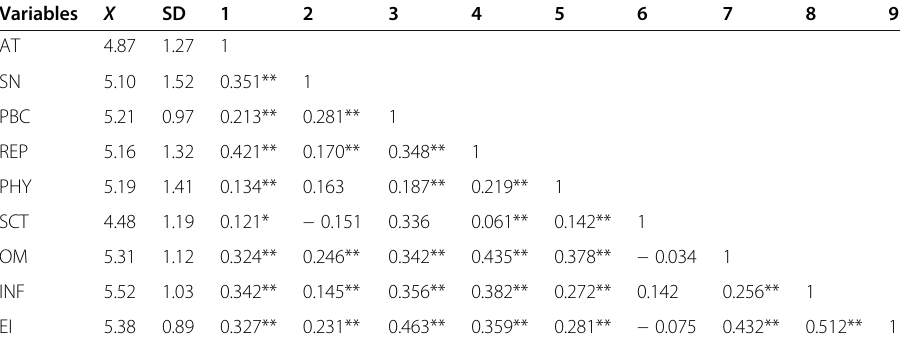
Table 1 Means, standard deviation and correlation Variables